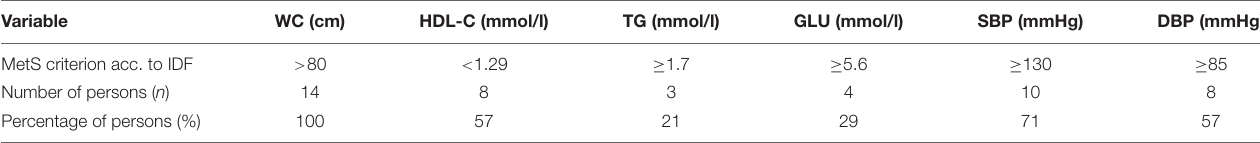
TABLE 1 | Number of persons meeting individual criteria of metabolic syndrome (MetS) in accordance with 2005 IDF assumptions (Alberti et al., 2006).